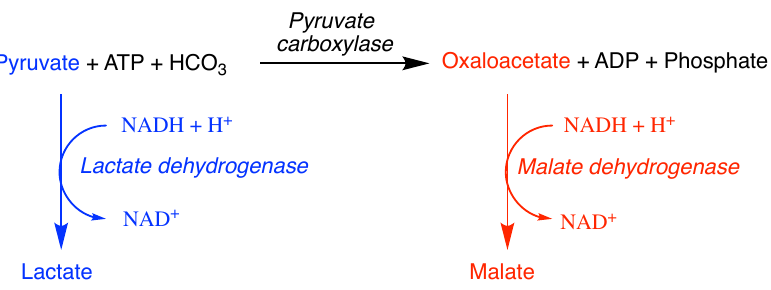
Figure 3. Interference with the assay of pyruvate carboxylase. The assay, based on measurement of malate dehydrogenase-catalysed reduction of oxaloacetate oxidation by NADH + H + , which can be followed spectrophotometrically at 340 nm, is shown in red, with the interfering reaction catalysed by lactate dehydrogenase in